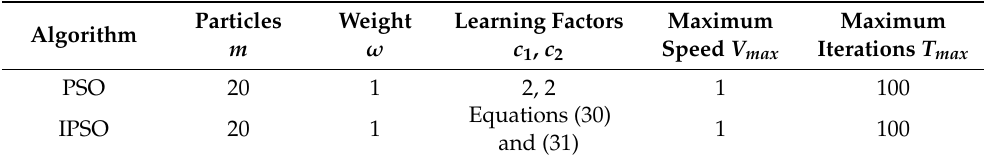
Table 1. Parameter settings for different PSO algorithms.